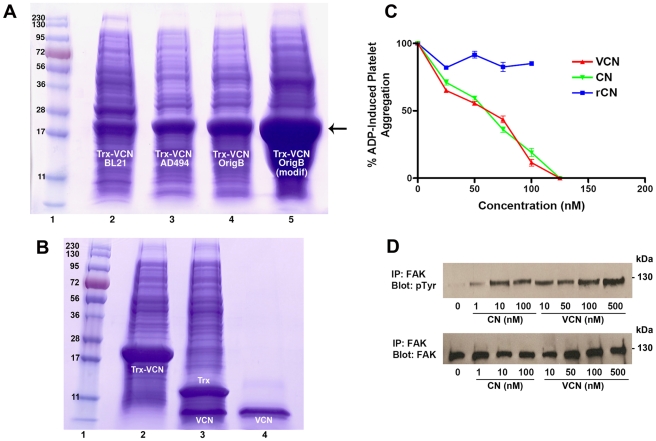
The expression, purification and initial characterization of VCN as an active disintegrin.
Panel A – The production of Trx-VCN was assessed in different E. coli strains that were transformed, grown, induced, and processed under identical conditions. The same amount (5 µl) of cell lysates from each induced strain was loaded on a precast gel and Coomassie stained. Unlike the BL21 (DE3) strain, the lysates from both AD494 (DE3) and Origami B (DE3) strains generate a unique and consistent Trx-VCN band (shown by the arrow). By employing a modified media recipe, the Origami B (DE3) Trx-VCN transformants achieve higher cell densities at the end of the induction time, generating up to 200 mg of soluble VCN per L of bacterial culture after purification. Panel B – Coomassie stained gel showing the migration of Trx-VCN before and after TEV proteolysis (lanes 2 and 3, respectively) versus C18 reverse phase-HPLC purified VCN (lane 4). Panel C
– VCN and native CN exhibit an almost identical dose-dependent inhibitory effect against ADP-induced platelet aggregation when incubated with human platelet-rich plasma (with a calculated IC50 of ∼60 nM). In contrast, the rCN construct, which is also expressed as a soluble polypeptide in Origami B (DE3), shows no inhibitory activity. Panel D
– The agonistic activity of VCN (FAK activation) was assessed in serum-starved non-migratory MDA-MB-435 cells kept in suspension and exposed to increasing concentrations of disintegrins for 30 min. Similar to dimeric CN, VCN is also shown to engage integrins agonistically (outside-in signaling).